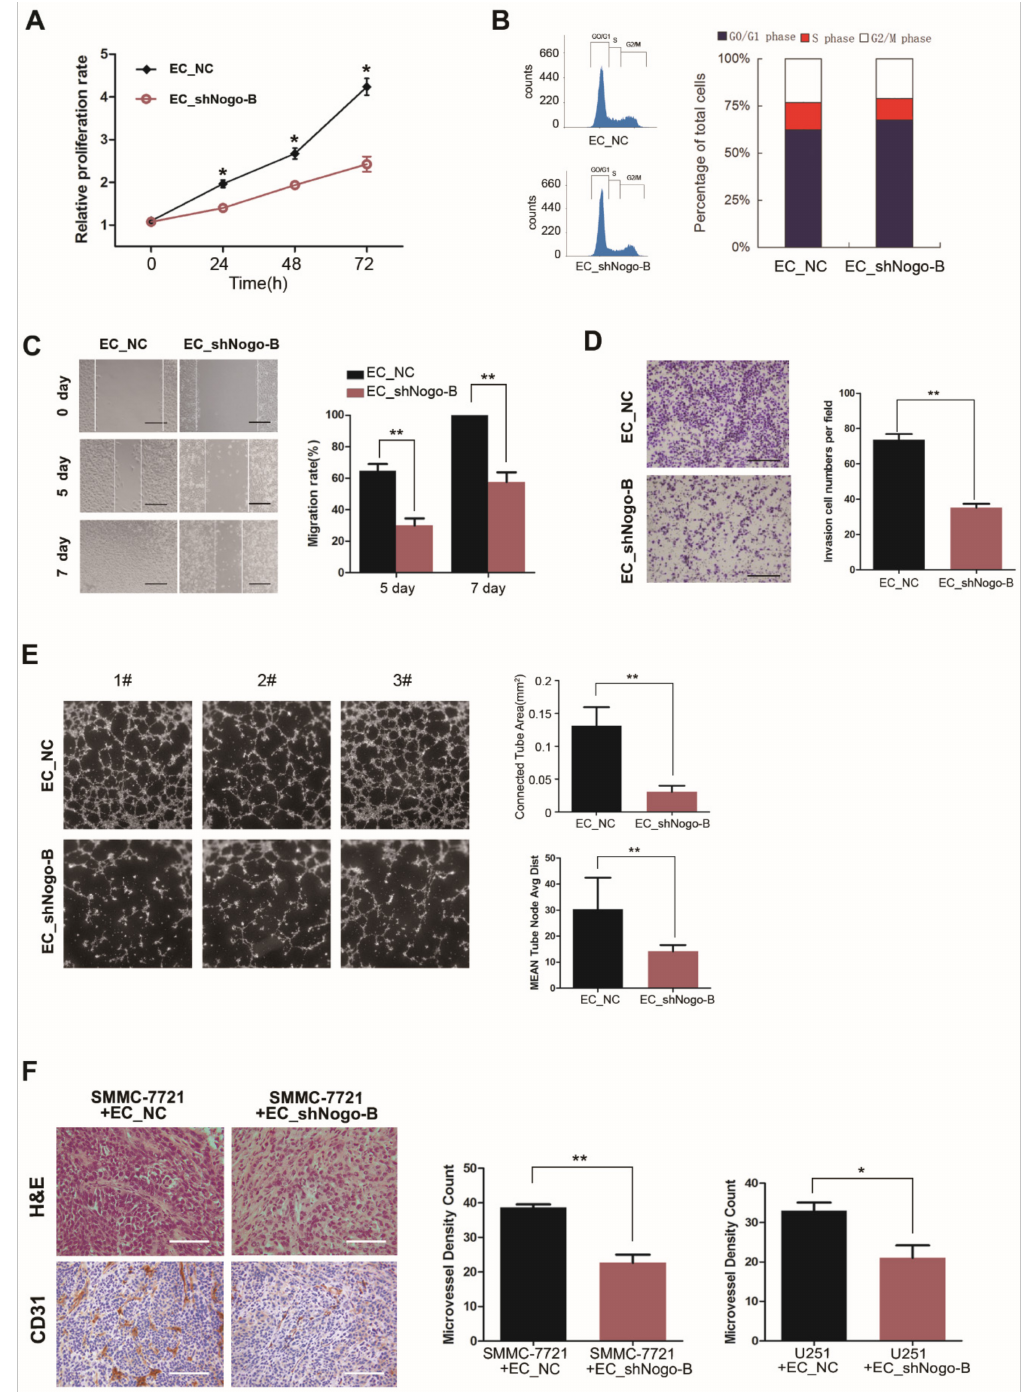
Figure 3. Endothelial Nogo-B promotes angiogenesis. ( A ) The proliferation of EC_NC and EC_shNogo-B was compared using the CCK8 assay. “*” indicates p < 0.05. ( B ) The cell cycle distributions of EC_NC and EC_shNogo-B were analyzed by flow cytometry, and the proportion of EC_shNogo-B in S-phase was significantly lower than EC_NC. ( C ) The migration abilities of EC_NC and EC_shNogo-B were compared using the wound healing assay. Black scale bars, 50 µ m. “**” indicates p < 0.01. ( D ) A Transwell invasion assay was performed to compare the migration abilities of EC_NC and EC_shNogo-B. Black scale bars, 100 µ m. “**” indicates p < 0.01. ( E ) A tube formation assay was conducted using EC_NC and EC_shNogo-B. The area under the vascular